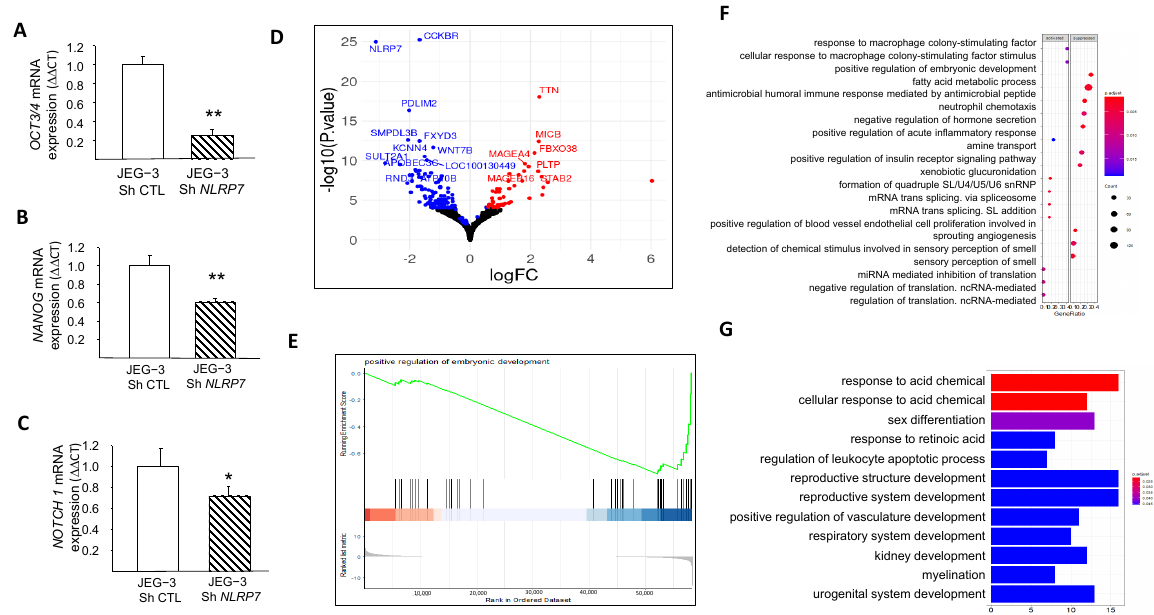
Figure 4. Comparison of JEG-3 cells differentiation under NLRP7 knockdown. ( A ) presents a comparison between JEG-3 Sh CTL and JEG-3 Sh NLRP7 of mRNA levels for OCT3/4 expression ( n = 3); ** p < 0.01. ( B ) presents a comparison of mRNA levels for NANOG expression in JEG-3 Sh CTL and JEG-3 Sh NLRP7 ( n = 3); ** p < 0.01. ( C ) shows a comparison of mRNA levels for NOTCH 1 expression in JEG-3 Sh CTL and JEG-3 Sh NLRP7 ( n = 3); * p < 0.05. ( D ) displays a volcano plot that presents a logarithmic representation of the fold change between expression levels in JEG-3 Sh NLRP7 versus JEG-3 Sh CTL for each gene, along with a logarithmic representation of the adjusted p -value generated from differential gene expression analysis. Red dots indicate significantly upregulated genes (adjusted p -value < 0.05 and absolute log2 fold change > 1.2), and blue dots indicate significantly downregulated genes (adjusted p -value < 0.05 and absolute log2 fold change < 1.2). ( E ) reports the GSEA enrichment plot of the regulation of the embryonic development pathway. The running enrichment score (ES) for the gene set is displayed in the top portion of the plot, with a positive ES indicating gene set enrichment at the top of the ranked gene list (i.e., genes overexpressed in JEG-3 Sh NLRP7 ). The middle portion shows the position of the members of the gene set in the ranked list of genes, and the bottom portion displays the logarithmic representation of the fold change between expression levels in JEG-3 Sh NLRP7 versus JEG-3 Sh CTL cells used as gene ranking metrics. ( F ) presents a dot plot that represents the most significantly enriched molecular processes identified by the GSEA method. The top 20 activated or suppressed pathways were selected based on their enrichment in under- or over-expressed genes in JEG-3 Sh NLRP7 , respectively, with the gene ratio indicating the proportion of genes deregulated by the pathway in relation to the total number of genes annotated by pathway. The red dashed box highlights key pathways of embryonic development, while the blue dashed box highlights key pathways of adaptive immune responses. ( G ) displays a bar plot that represents the most significantly enriched biological processes identified by the GSEA method. The top 12 activated or suppressed pathways were selected based on their enrichment in under- or over-expressed genes in JEG-3 Sh NLRP7 , respectively, with the gene ratio indicating the proportion of genes deregulated by the pathway in relation to the total number of genes annotated by pathway. The red dashed box highlights key pathways of embryonic development, while the green dashed box highlights key pathways of adaptive immune